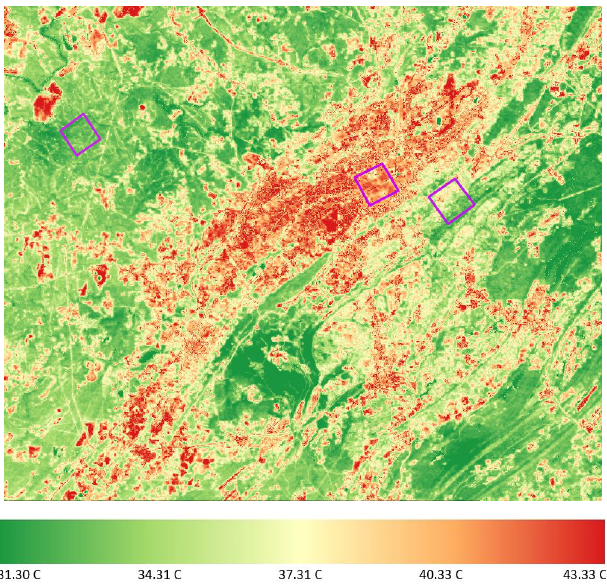
Figure 11. Converted LST (land surface temperature) for the Birmingham metropolitan area of AL on 14 August 2007. The unit is ◦ C. The three boxes in purple refer to the selected rural, urban and suburban sites, from west to east, as in Figure